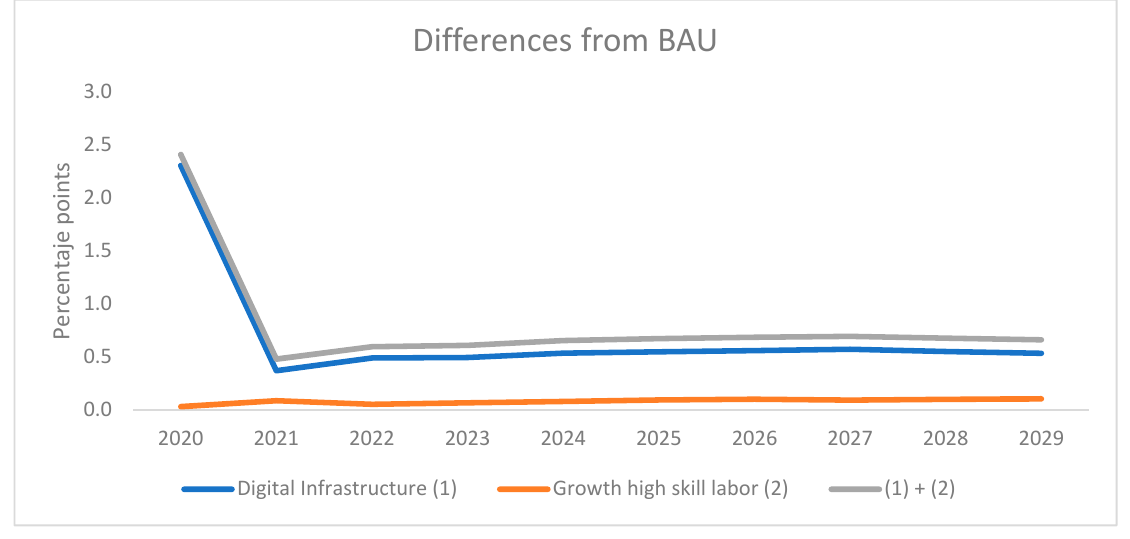
Figure 9. GDP Growth Effects of Digital Infrastructure Development. Source: Authors’ calculations.